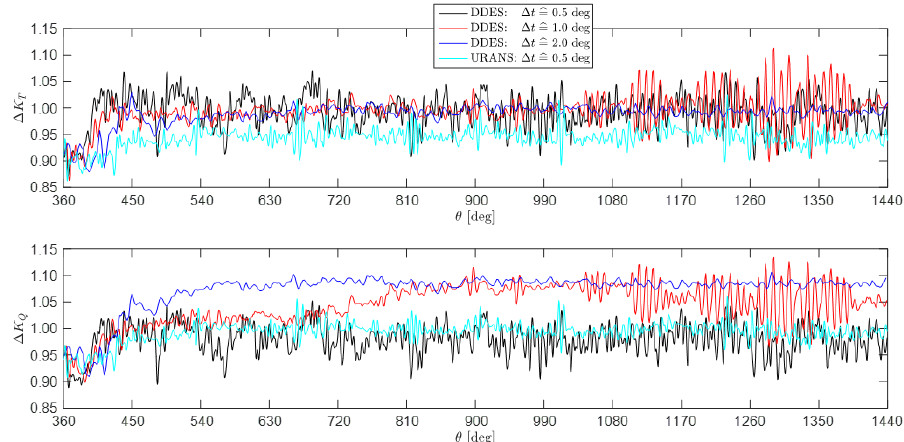
Figure 19. Time histories of the propeller thrust coefficient for PPTC Case 2. Model-scale DDES and URANS simulations with different time-steps.